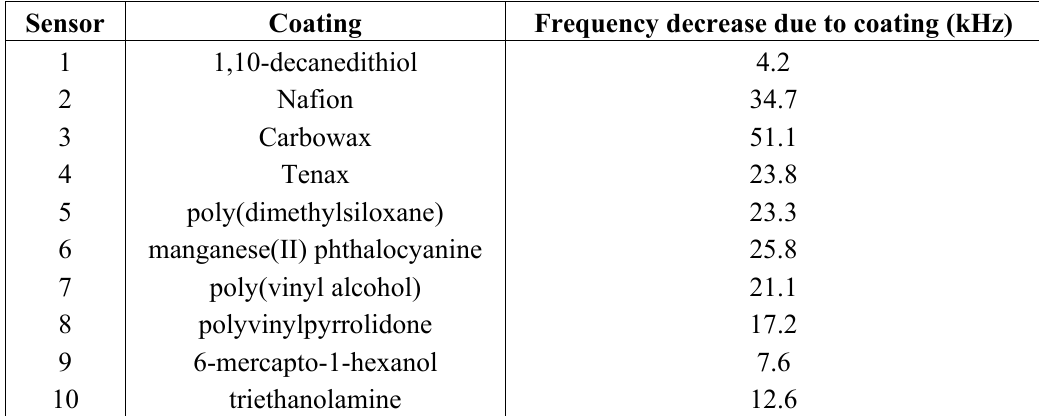
Table 2. sensors’ coatings, and frequency decreases due to